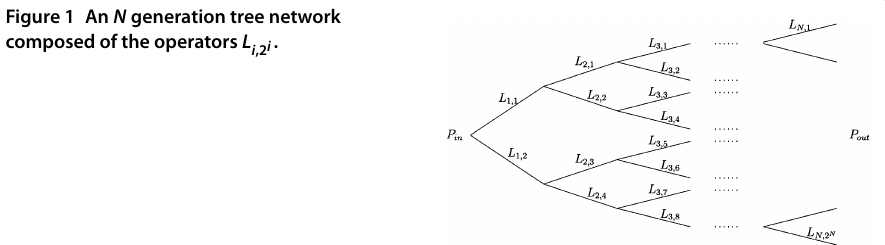
Figure 1 An N generation tree network composed of the operators L